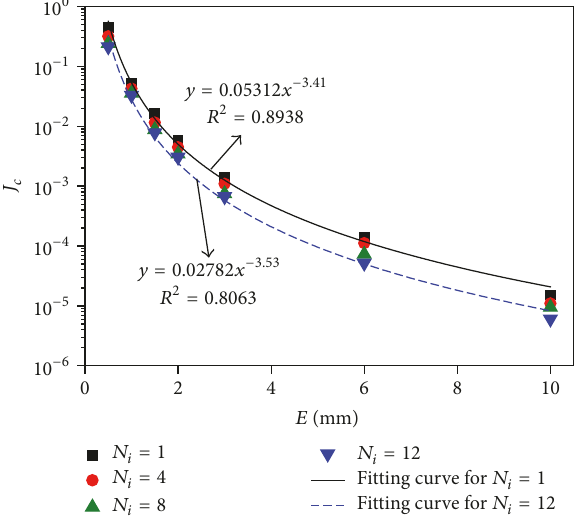
Figure 17: Relationships between 𝐽 𝑐 and 𝐸 based on the data replotted from Liu et al. ([36], Figure 6